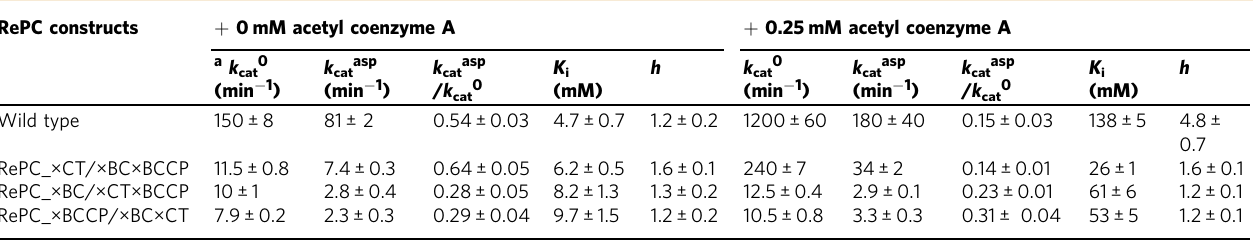
puri fi ed sample, where each independent L -aspartate concentration was measured four independent times (Supplementary Fig. 5). The standard errors are reported for K i and h . All assays were performed in the presence of 25mM NaHCO 3 , 2.5mM MgATP, 12mM pyruvate, ±0.25mM acetyl CoA and 0 – 300mM L -aspartate